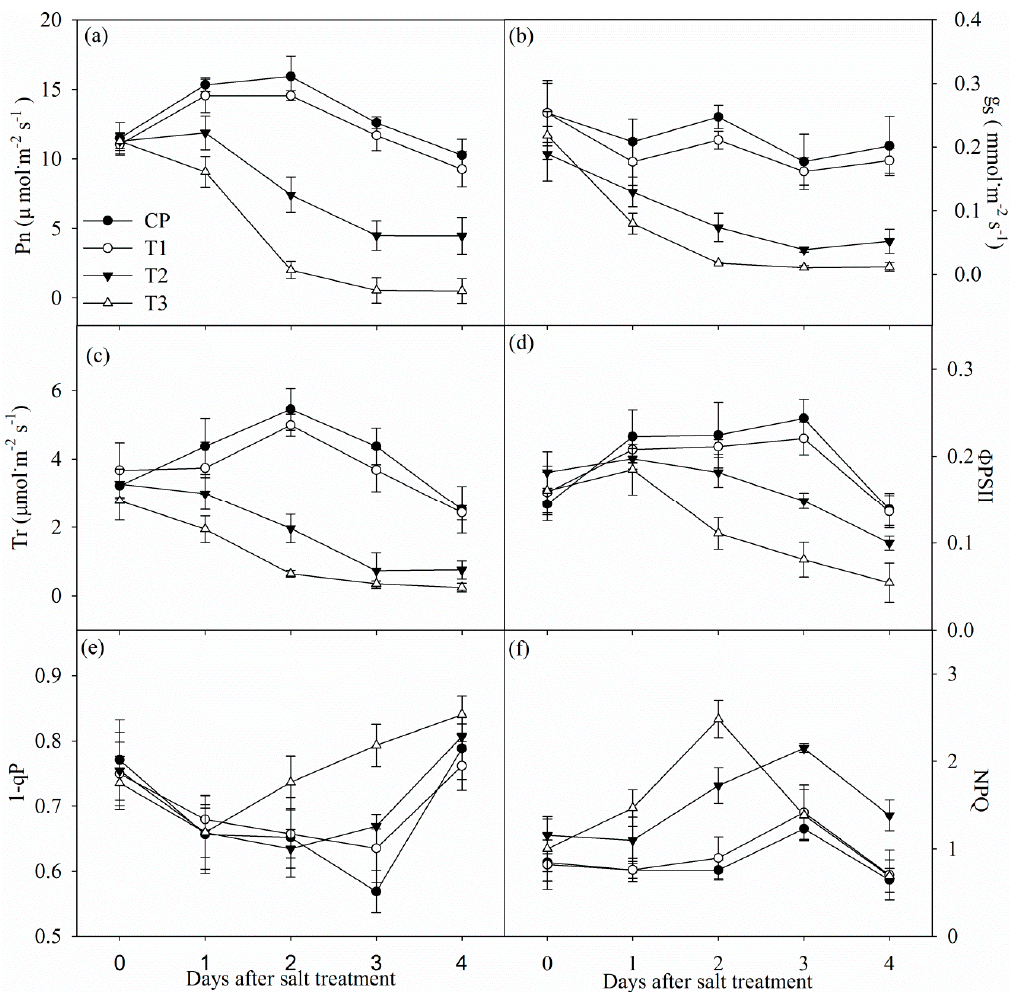
Figure 2. Changes in photosynthetic rate (Pn, ( a )), stomatal conductance (g s , ( b )), transpiration (Tr, ( c )), actual photochemical efficiency of PSII ( Φ PSII, ( d )), PSII excitation pressure (1-qP, ( e )) and non- photochemical quenching (NPQ, ( f )) in Jerusalem artichoke under salt stress. Data in the